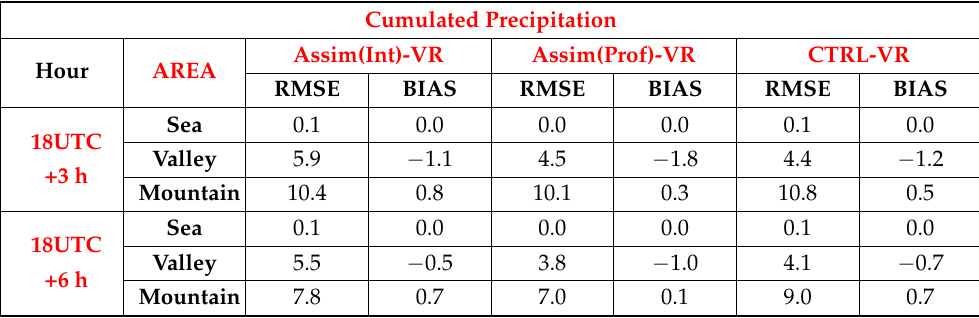
Table A3. As in Table A1, but for accumulated precipitation, up to 3 and 6 h after assimilation